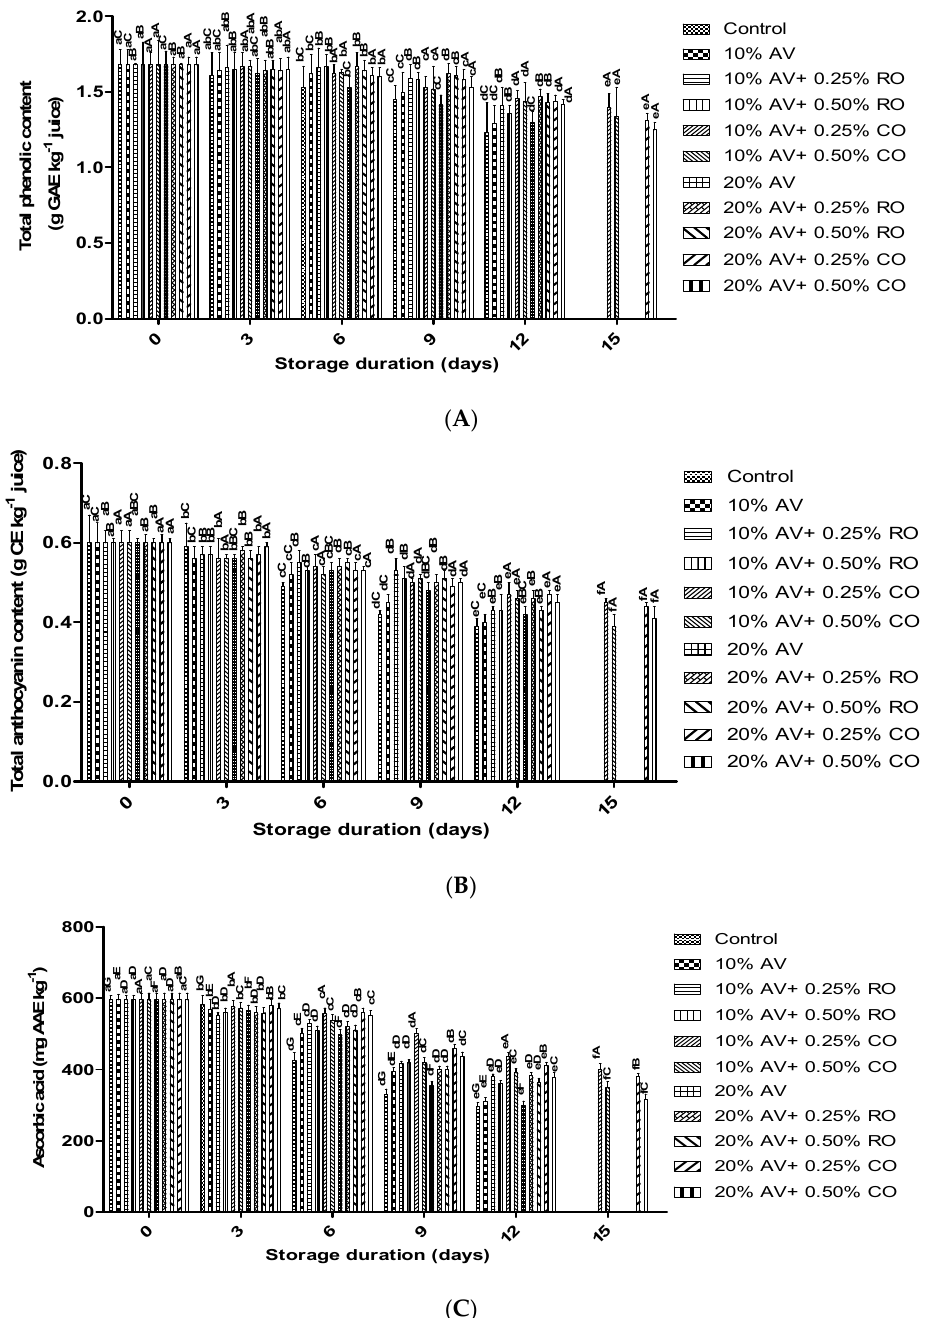
Figure 7. ( A ) Total phenolic content (g GAE kg − 1 juice), ( B ) total anthocyanin content (g CGE kg − 1 juice), and ( C ) ascorbic acid (mg AAE kg − 1 ) of ‘Bhagwa’ pomegranate arils that were coated with Aloe vera (AV) gel coatings that were enriched with rosehip oil (RO) (0.25% or 0.50%) and cinnamon oil (CO) (0.25% or 0.50%) and stored at 5 ± 1 °C (95 ± 2% RH) for 15 days. The vertical bars represent the standard deviation (SD) of the mean values of three replicates (1 punnet = 1 replicate, n = 3). Values bearing at least one common small superscript (a,b,…, etc.) and at least one common capital superscript (A,B,…, etc.) letters differ significantly between the days and between the coating solution/concentrations, respectively, at p < 0.05 in Duncan’s multiple comparison post hoc test. The vertical bars represent the standard error (SE) of the mean values of three replicates (1 punnet = 1 replicate). The data are expressed in mean SE ( n = 3). The different letters in the same storage period indicate significant differences at p ≤ 0.05.